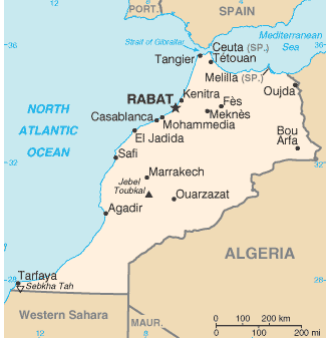
Figure 1. Geographic situation of the city of Melilla. © Wikimedia.org.